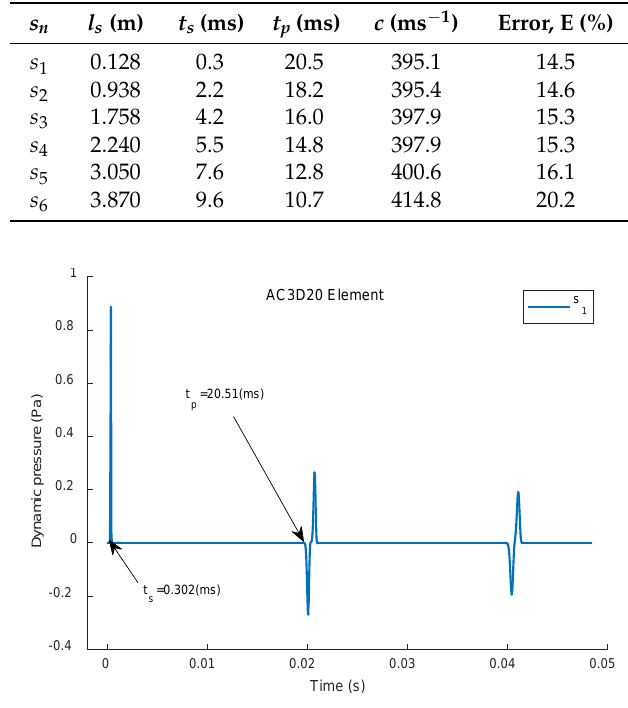
using AC3D20 element 𝑟𝑟 1